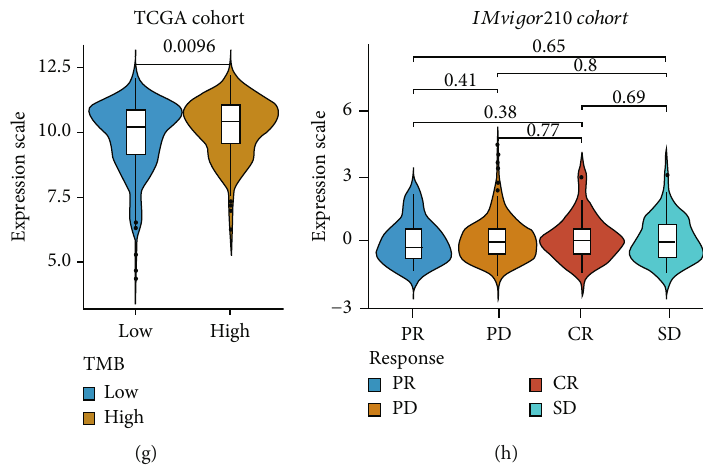
Figure 2: Relationship between m6A regulator expression and tumor immune cell in fi ltration in The Cancer Genome Atlas-colorectal cancer (TCGA-CRC) dataset. (a) Correlation and prognosis network of 21 m6A regulators in patients with CRC. (b) Correlation heat map between immune cell in fi ltrates and 21 m6A regulator expression. (c) Gene set enrichment analysis (GSEA) for high and low YTHDC2 expression status. (d) Correlation between overall survival (OS) and YTHDC2 expression in TCGA-CRC cohort (log-rank test, P = 0 : 0072 ). (e) Correlation between OS and YTHDC2 expression in IMvigor210 cohort (log-rank test, P = 0 : 016 ). (f) Di ff erences in YTHDC2 expression across anatomical locations in TCGA-CRC dataset. (g) Di ff erences in YTHDC2 expression and tumor mutational burden in TCGA-CRC dataset. (h) A boxplot showing relative YTHDC2 expression in di ff erent clinical response